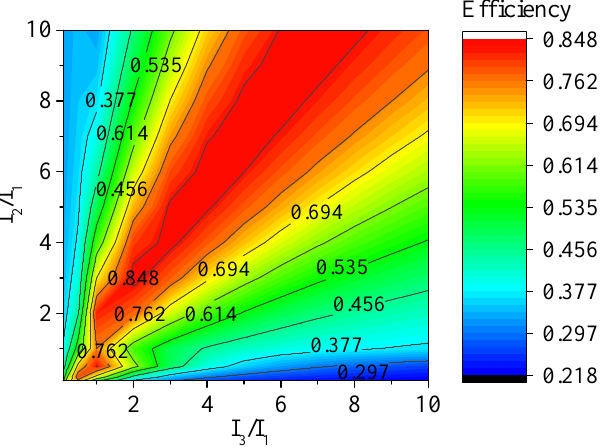
Figure 8. The simulated efficiency η as a function of the ratio of the input currents. The efficiency is always lower than the optimal current distribution I 2 / I 1 = 3 and I 3 / I 1 = 2. For example, if all input current sources are equal (i.e., I 2 / I 1 = 1 and I 3 / I 1 = 1), an efficiency of 76.2% is attained.